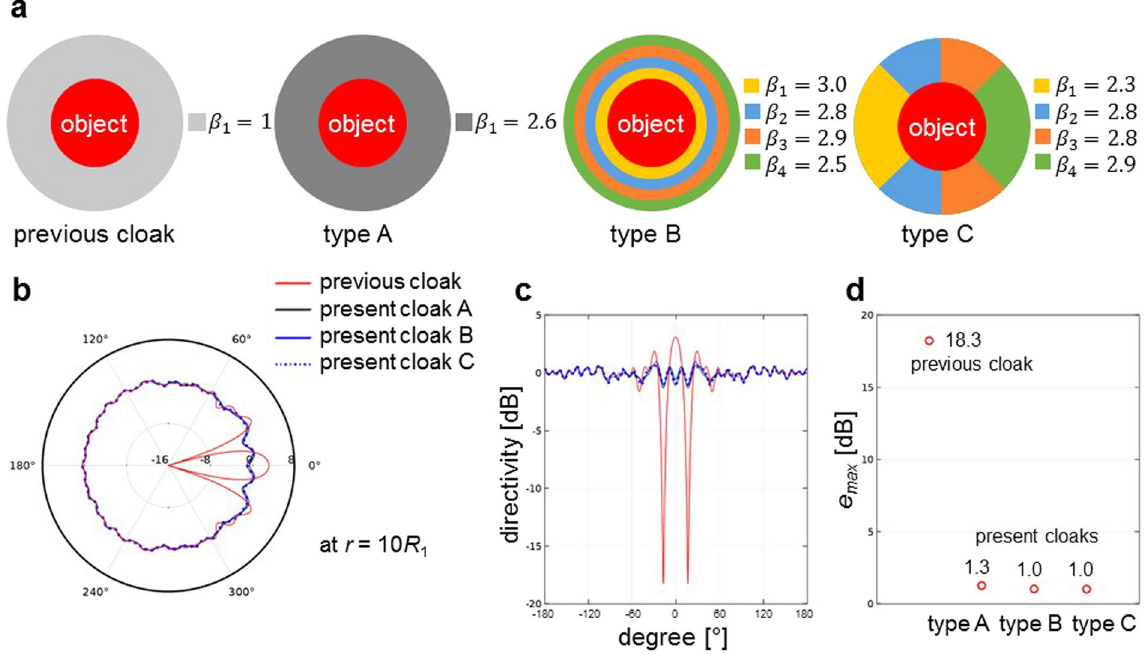
Figure 8. Shapes, material properties, and performances of newly designed convective cloaks. ( a ) Schematics of acoustic cloaks with modified material properties as shown in equation (9). Type A shows a single-zone modification ( N = 1) with optimized value of β 1 , and types B and C show multiple-zone modifications ( N = 4) with optimized values of β i for i = 1, 2, 3, 4. ( b ) Polar plot of directivity patterns of the previous and present cloaks in moving medium for M = 0.2. ( c ) Rectangular plot of directivity patterns of the previous and present cloaks in moving medium for M = 0.2. The directivity patterns are calculated in dB scale by using equation (5) at r = 10 R 1 . ( d ) Maximal errors calculated by using equation (8) at r = 10 R 1 for the previous and present cloaks. As shown in ( d ), three types of acoustic cloaks show better performance compared to the existing convective cloak 7